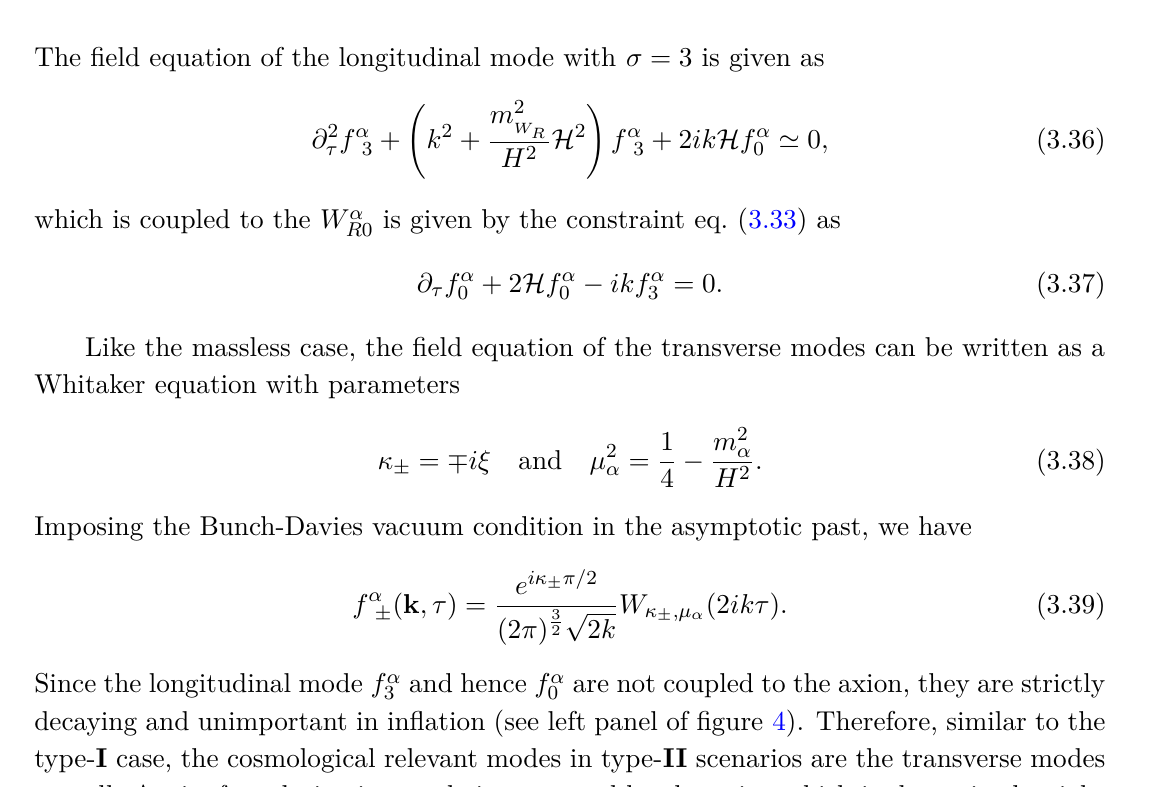
Figure 4 . The polarization states of massive gauge field vs k four components of the massive field ( f + corresponding modes in the massless case. Right panel shows the enhanced mode f different values of